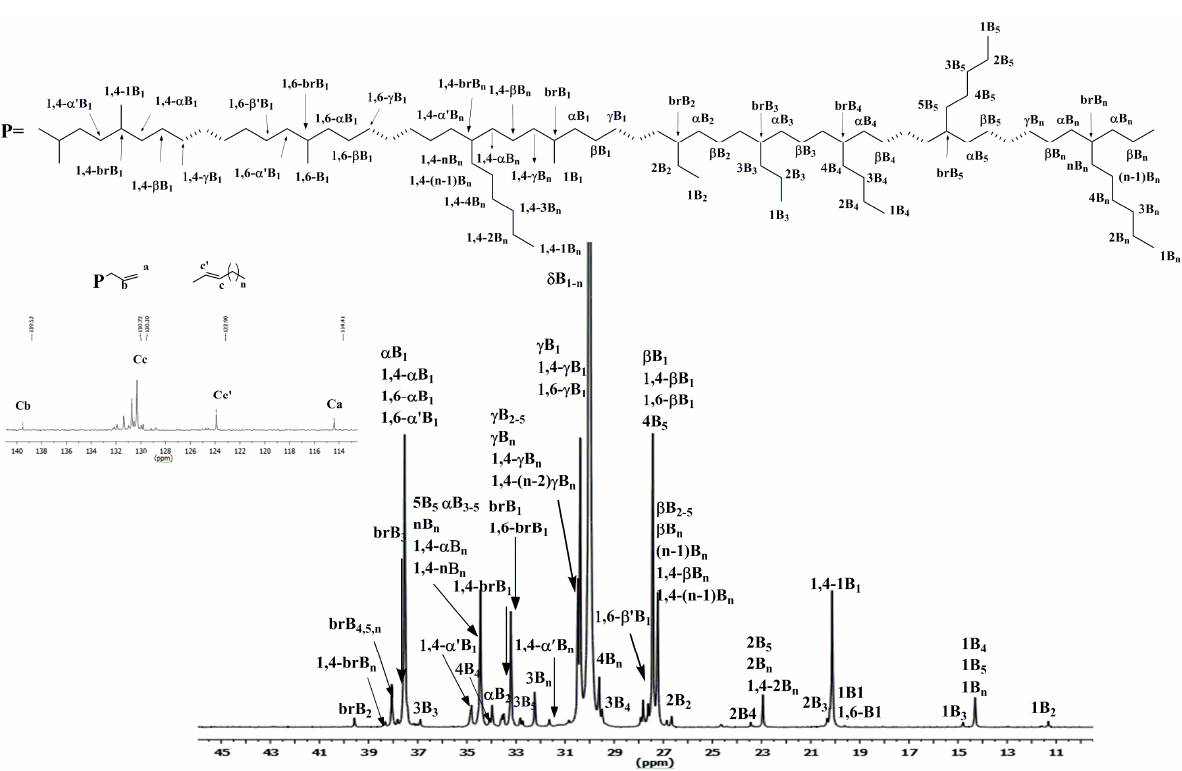
Figure 9. 13 C NMR spectrum of the PE produced using Ni1 /EtAlCl 2 at 30 °C (run 4, Table 3) recorded at 100 °C in d -C 2 D 2 Cl 4 .